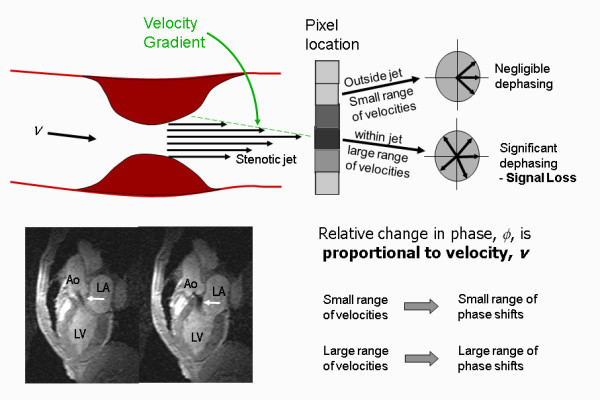
Signal losses caused by velocity gradients. This diagram illustrates how signal losses occur in the presence of stenotic or regurgitant flow jets. The two images (bottom left) show signal loss (white arrows) caused by aortic valve regurgitation at two end systole and early diastole. Flow jets consist of a large range of velocities, from very high velocities at the centre of the jet, to relatively low velocities at the edge of the jet (top left). The change in velocity from the centre to the edge of the jet is often referred to as a velocity gradient. Figure
33 shows that when bipolar gradients are applied within imaging pulse sequences, velocity related phase shifts occur. Where there is a large range of velocities due to a velocity gradient within a pixel, this results in a large range of phase shifts (right), causing significant dephasing and therefore signal loss within that pixel. Outside the jet there is only a small range of velocities leading to negligible dephasing and no signal loss.